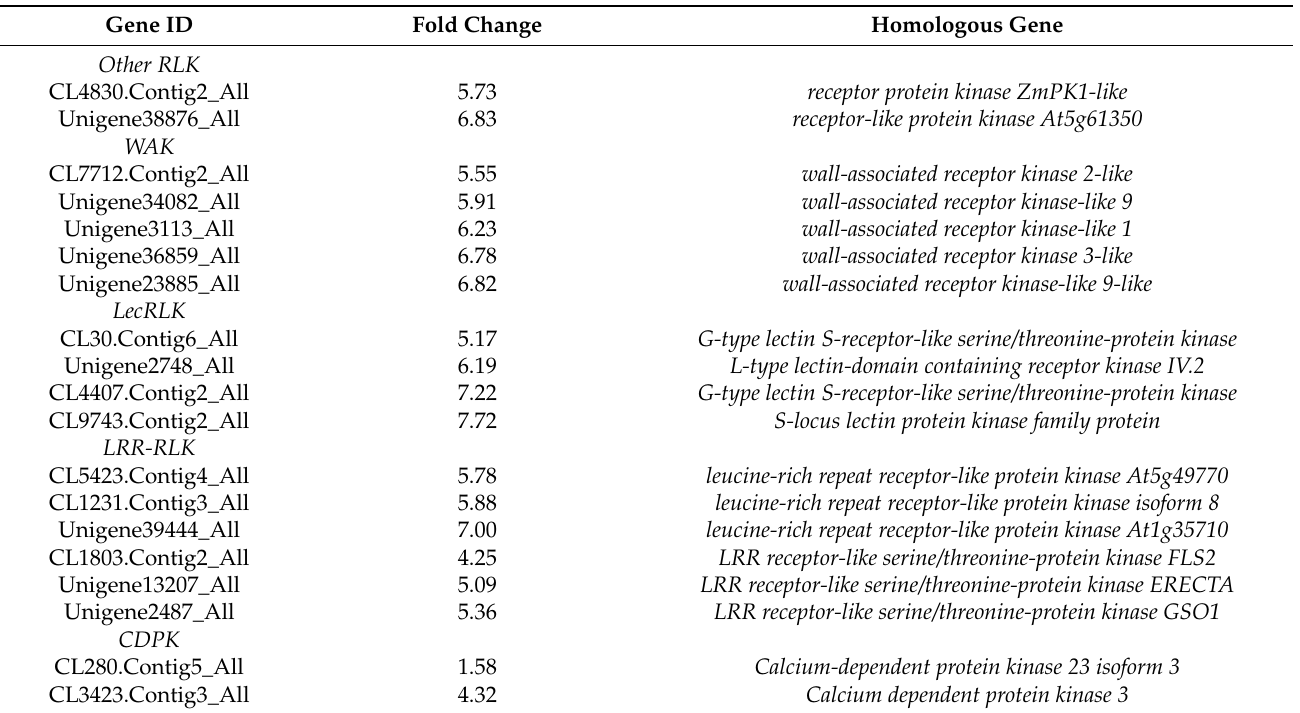
Table 16. The upregulated DEGs related to protein kinases in the roots of A. canescens under 100 mM NaCl, but not under control conditions, for 24